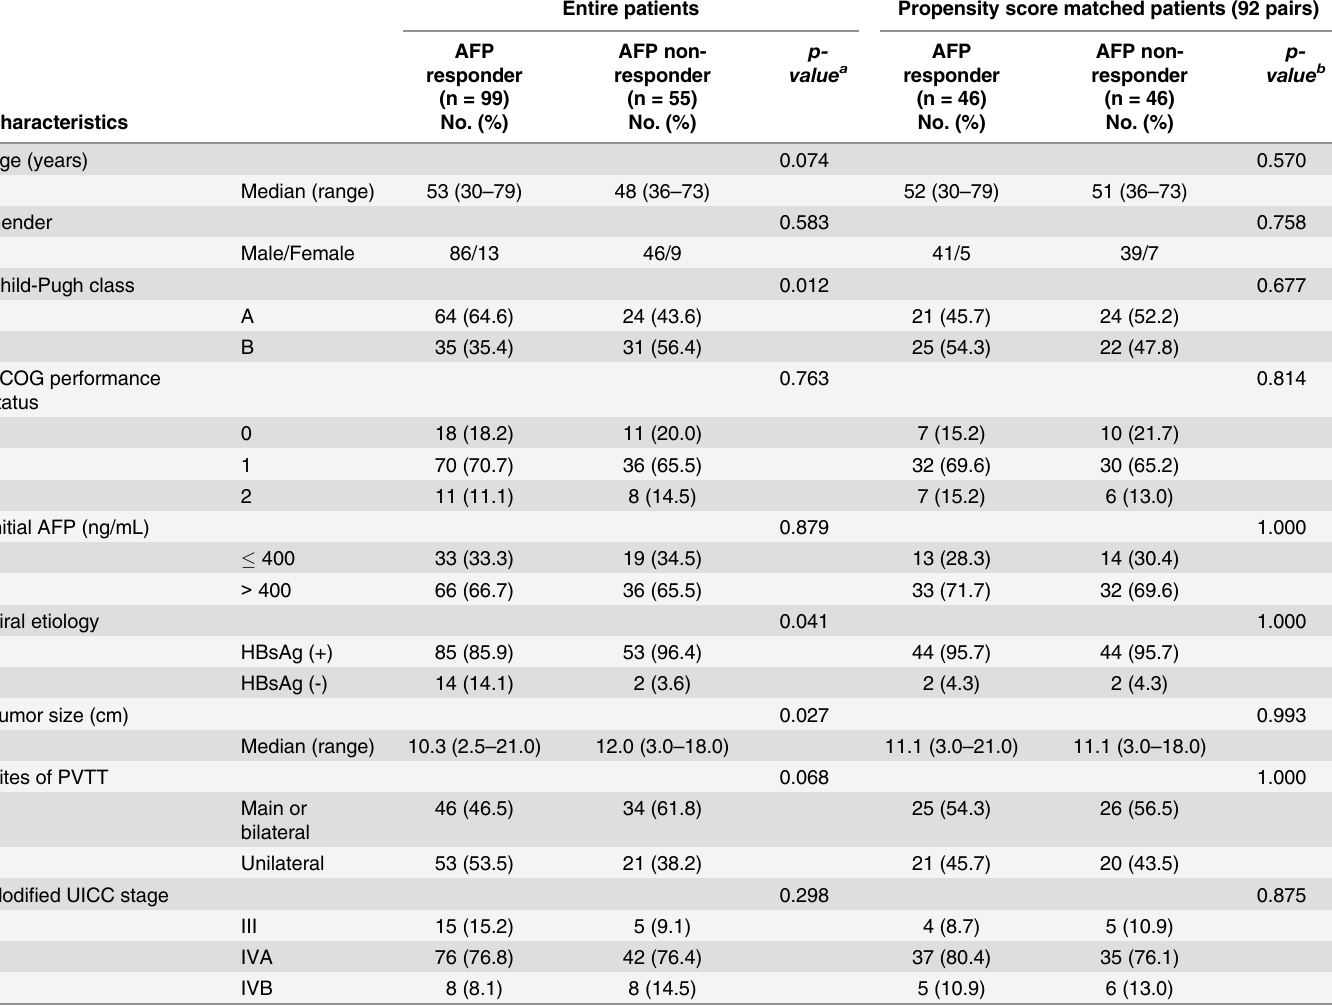
Entire patients Propensity score matched patients (92